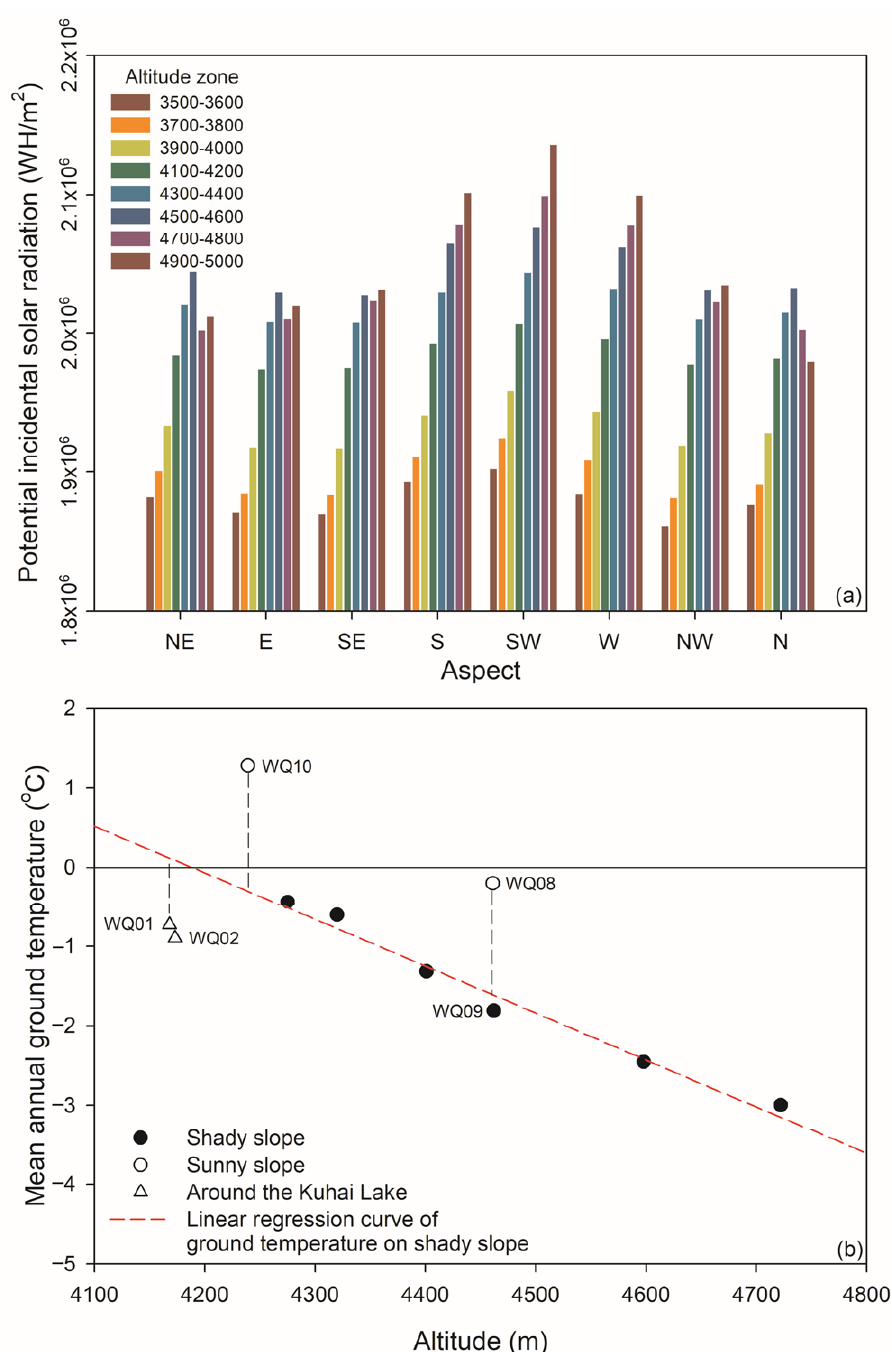
Figure 12. ( a ) Distribution of annual potential incident solar radiation at different aspects of the slope at different altitude zones; ( b ) differences in annual mean ground temperature observed from different borehole sites.